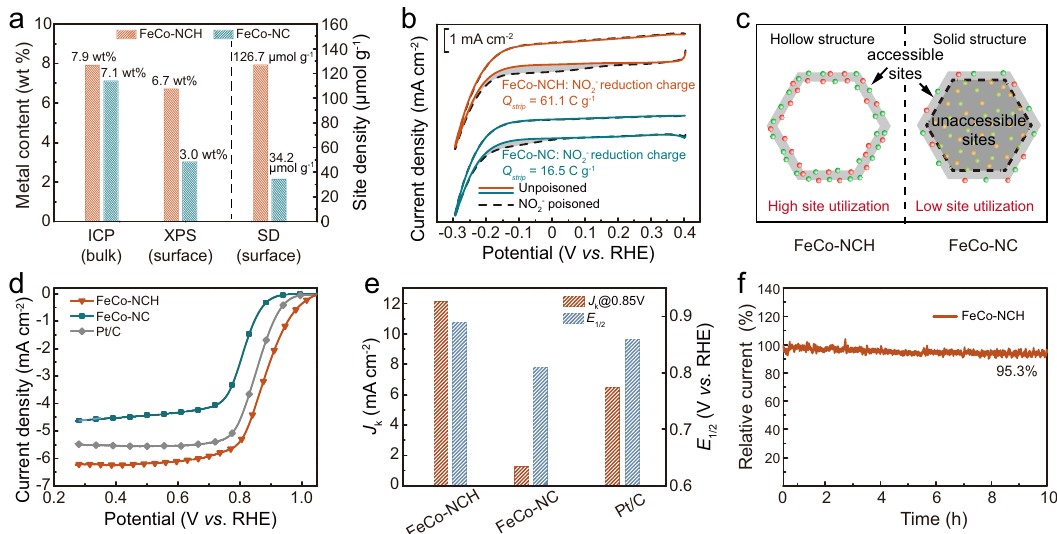
Fig. 4 | Evaluation of the site utilization and electrocatalytic performance of prepared catalysts for ORR. a The comparison of metal sites in FeCo-NCH and FeCo-NC, measured by XPS, ICP, and electrocatalytic measurements. b CV curves for FeCo-NCH and FeCo-NC under unpoisoned or NO 2 − poisoned conditions. c Scheme showing the hollow structure with high site utilization and the solid